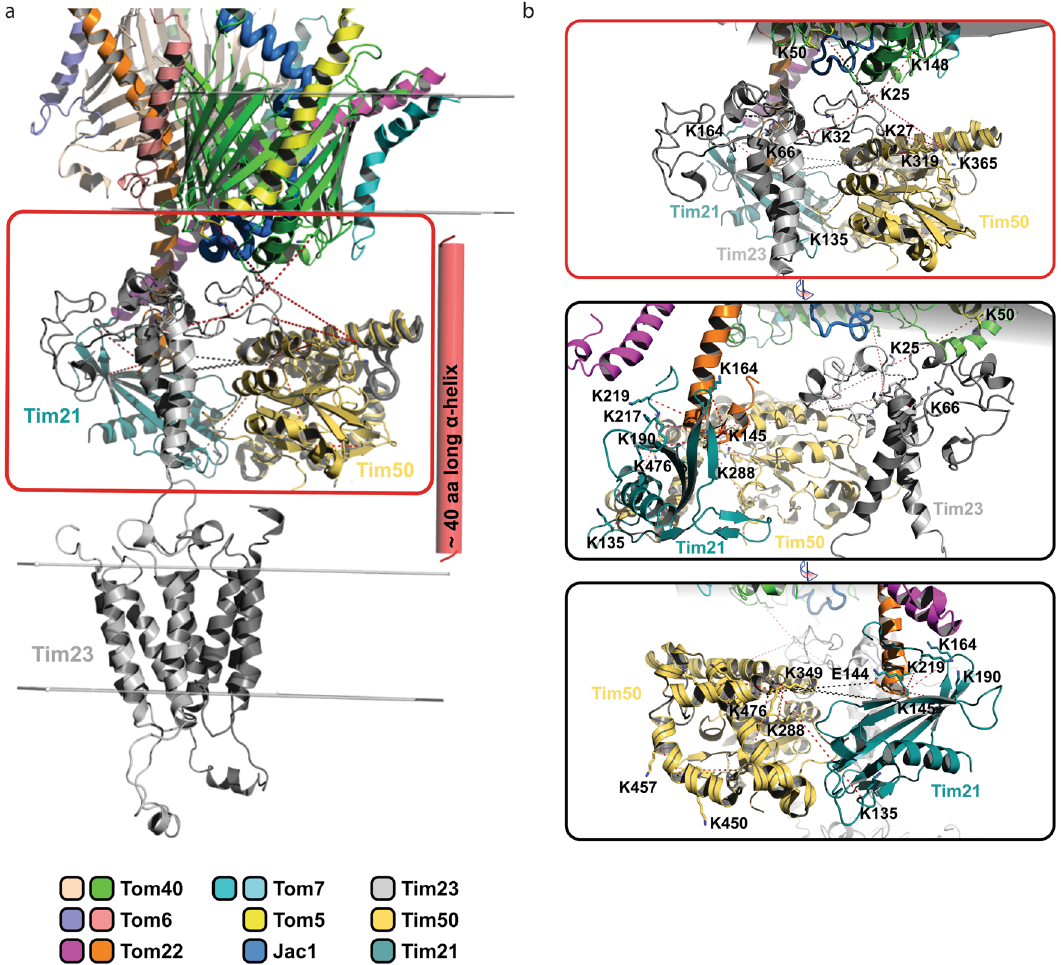
Fig. 5 Overview of inter-protein interactions in the IMS. a Schematic representation of the overall model of the TOM-TIM23 supercomplex in the presence of Jac1 sfGFP (blue ribbon), based on cross-links. b Zoomed inset from ( a ) in three different orientations, indicating cross-links between IMS domains of Tom22 (orange), Tim21 (cyan), Tim23 (gray), and Tim50